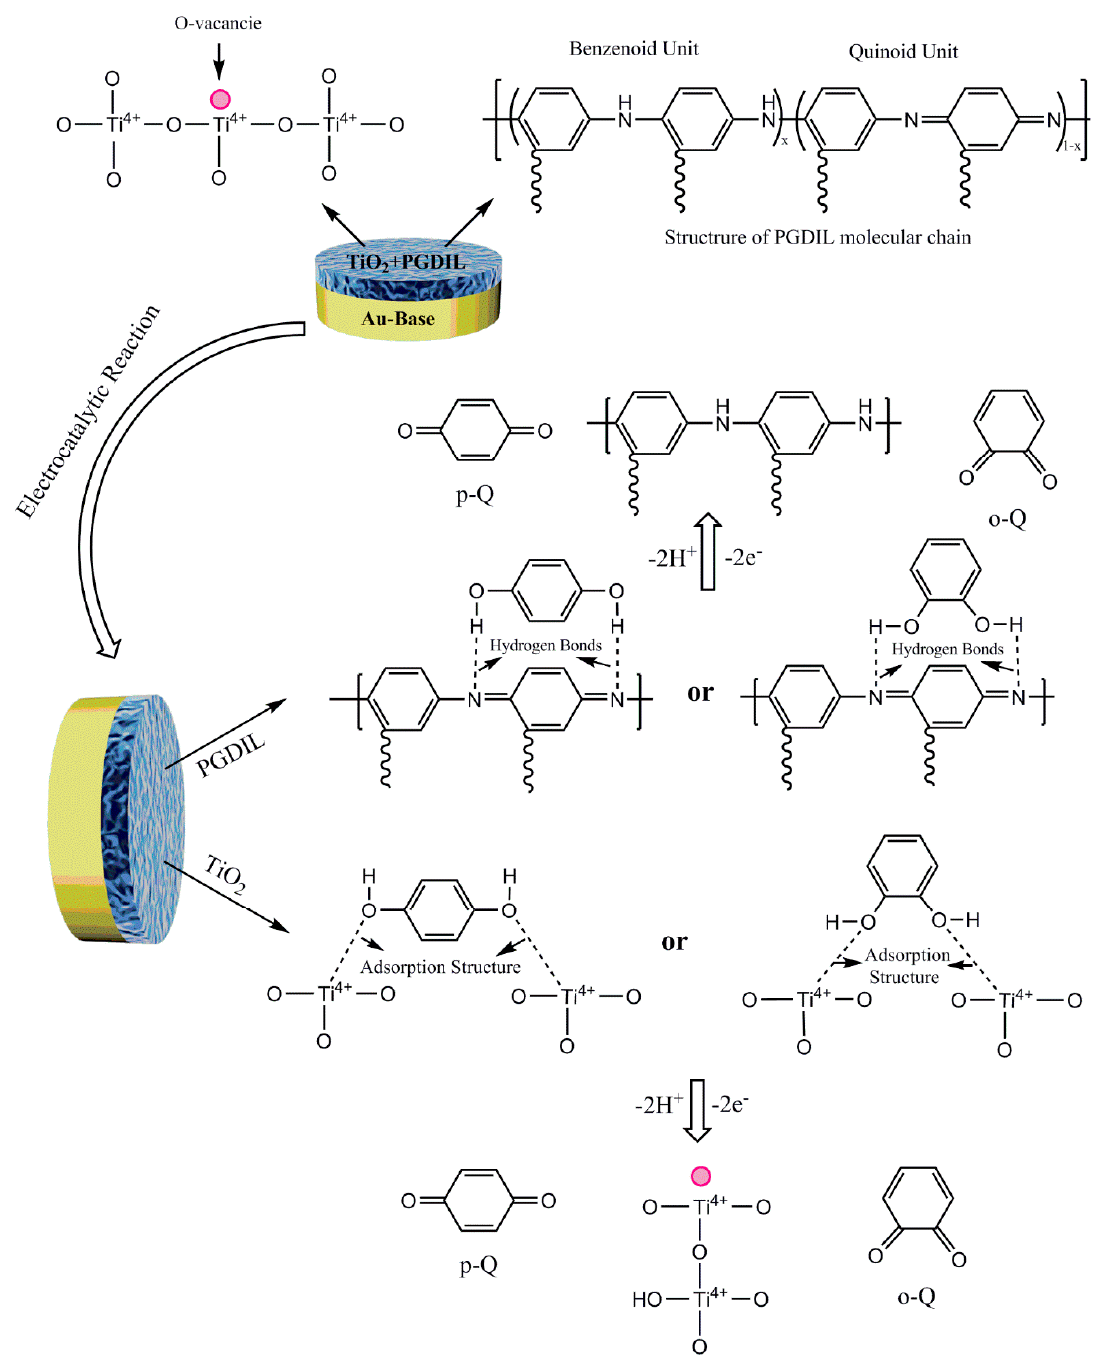
Scheme 1. Structure of PGDIL–TiO 2 and the oxidation processes of HQ and CC.